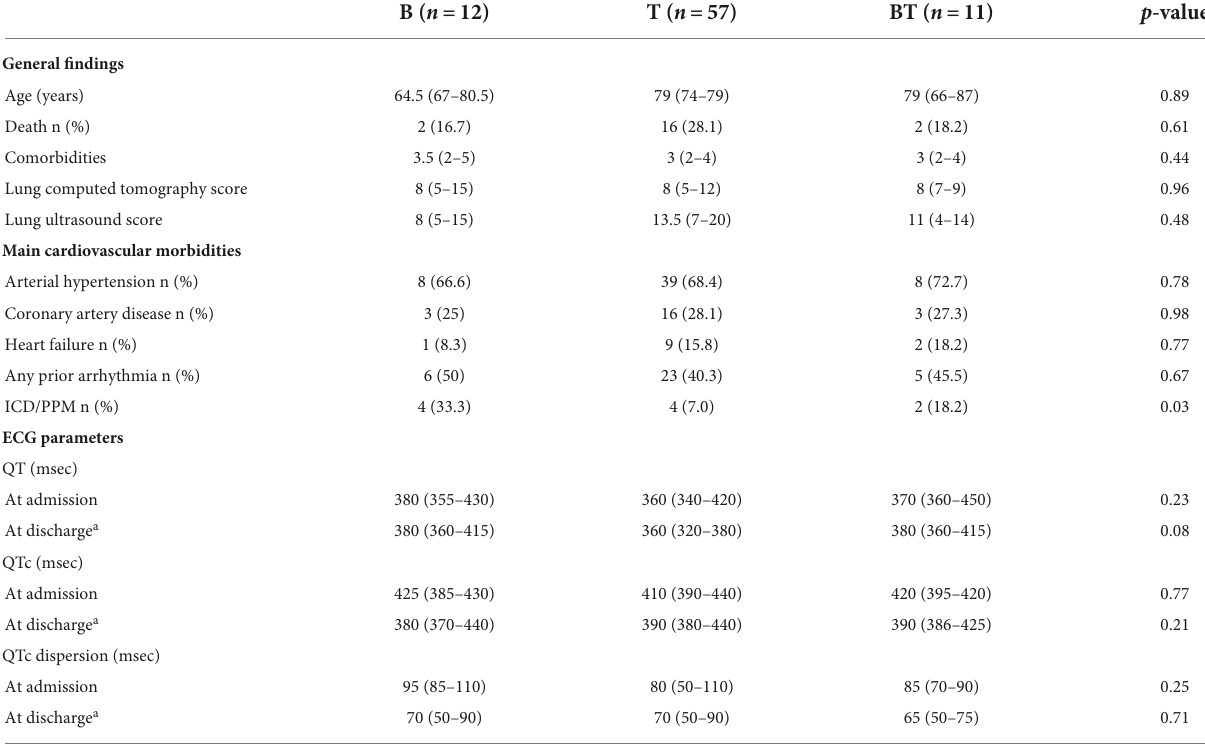
TABLE 3 General features, cardiovascular profile, and ECG measurements in the subgroups of patients with